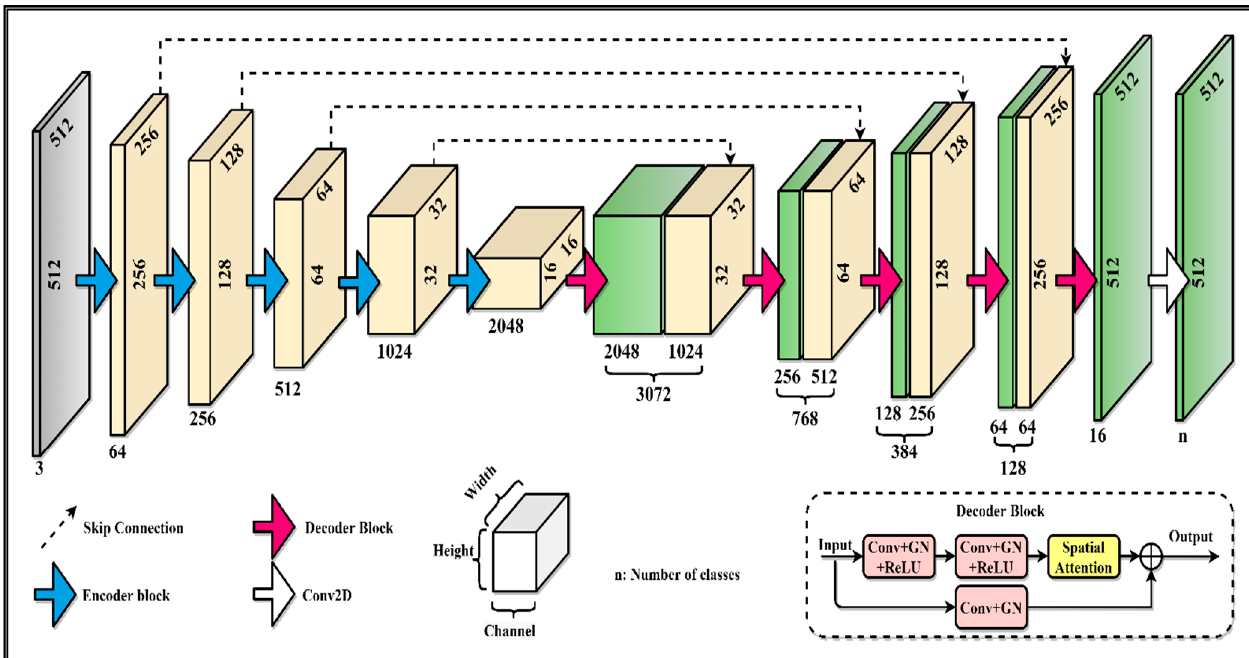
Figure 2. Details of our proposed model.